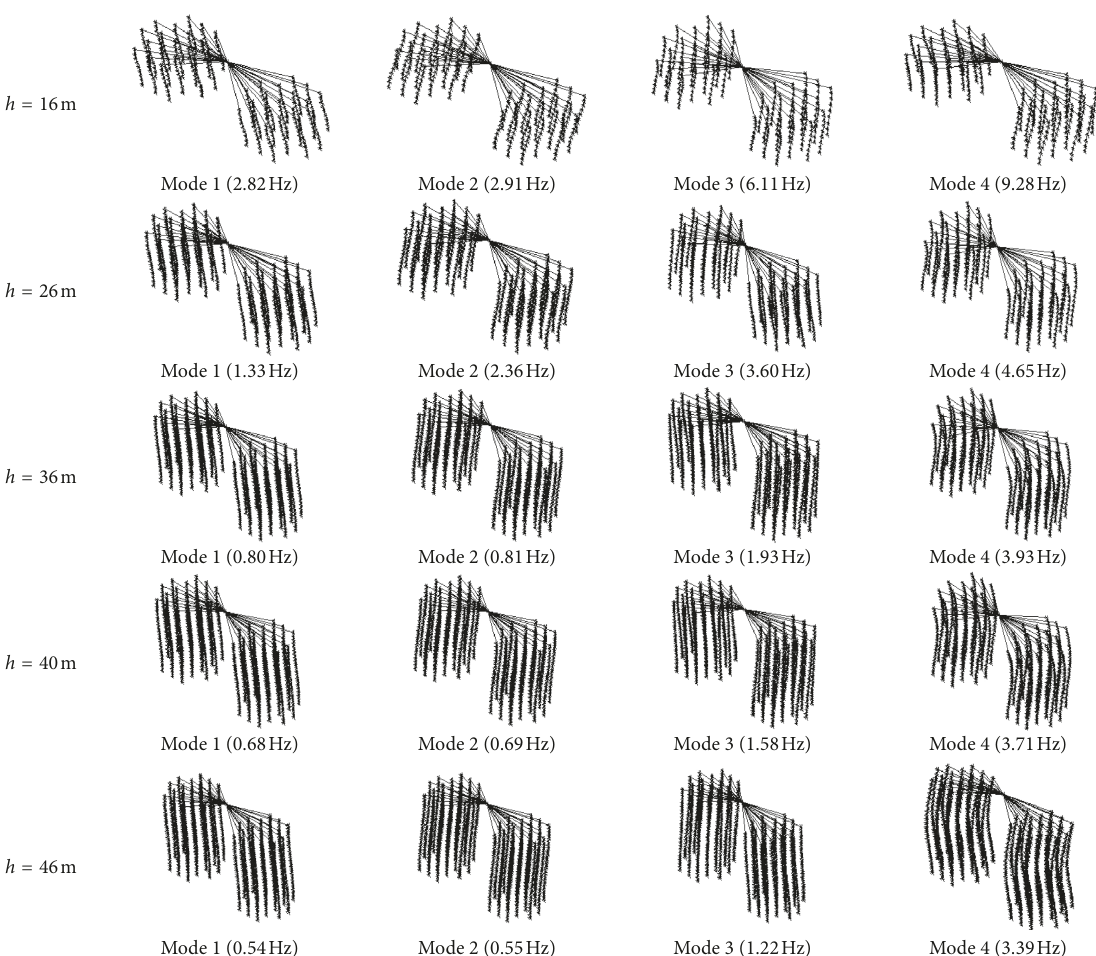
Figure 7: Dynamic characteristics of the foundations with different pile